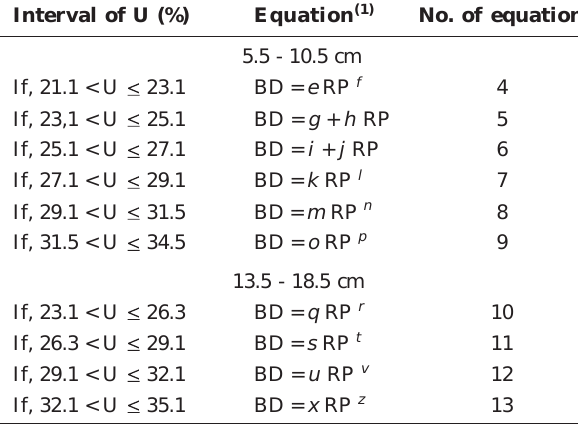
(1) e , f , g , h , i , j , k , l , m , n , o, p, q, r, s, t, u, v, x, and z are empiric parameters to adjust the